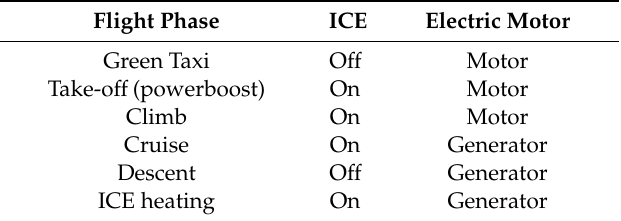
Table 1. Parallel hybrid propulsion system operative